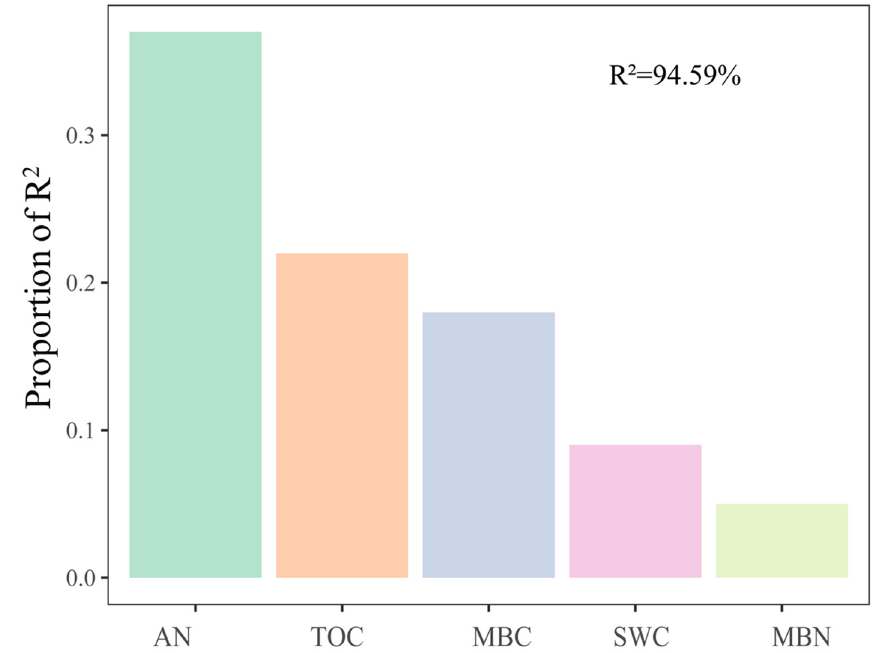
Figure 5. Relative importance of different predictors of fungal β -diversity. The values were calculated based on Bray–Curtis dissimilarity. Soil moisture content (SWC), available nitrogen (AN), organic carbon (TOC), microbial biomass carbon (MBC), and microbial biomass nitrogen (MBN) were used as predictors of fungi β -diversity. R 2 indicates the total explanation. The importance values of all predictor variables were normalized to sum to 100%.